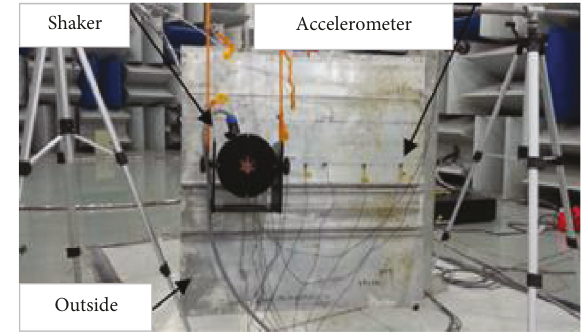
Figure 10: ESEA test process of incentive point B.